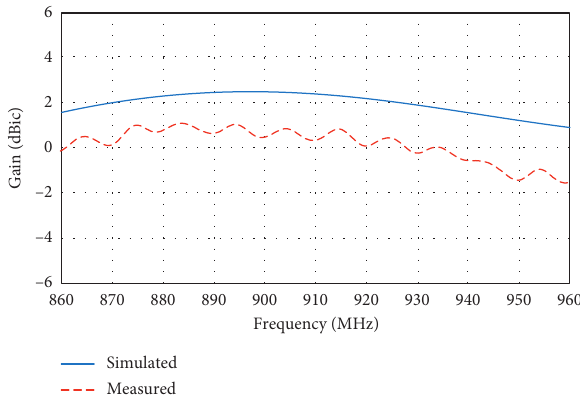
Figure 19: The simulated and measured gains of the UHF-RFID tag